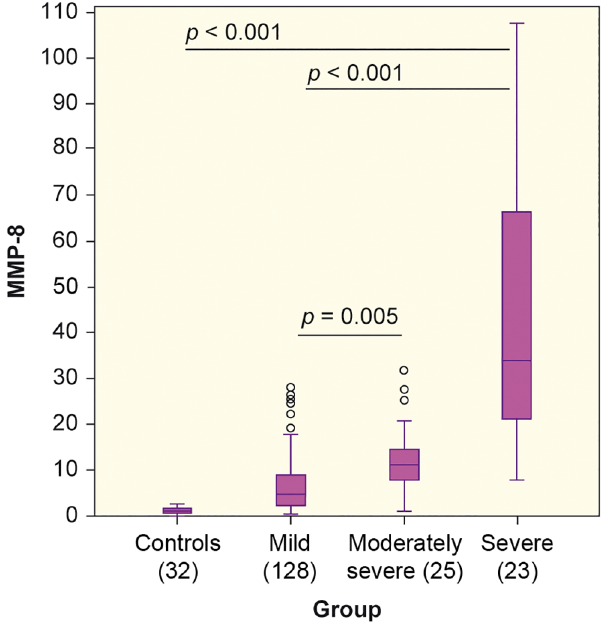
Fig 1. Levels of matrix metalloproteinase -8 (MMP-8) in patient groups and controls. Y-axis: MMP-8 in ng/ml. X-axis: Control subjects and patients classified by the revised Atlanta classification system.